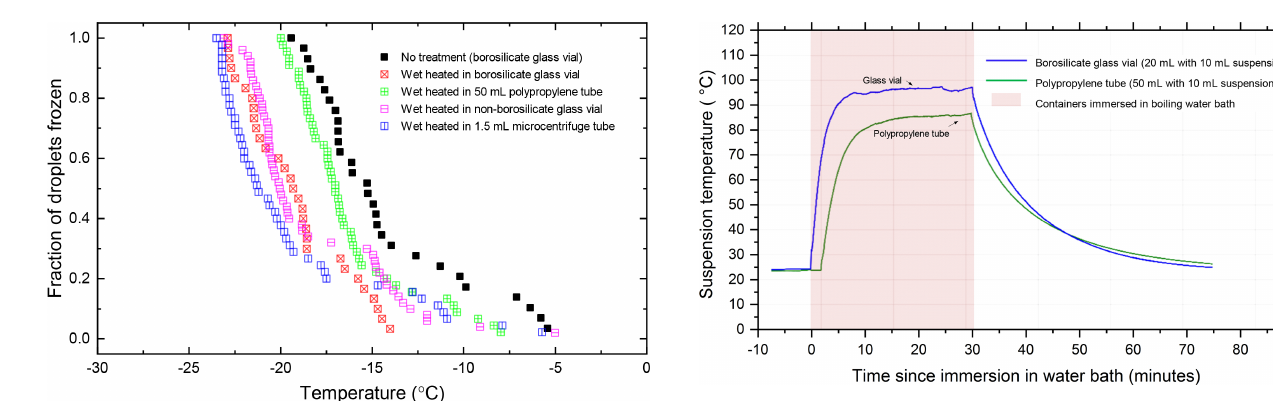
Figure A1. Plot showing the fraction of droplets frozen ( f ice (T ) ) for wet-heated Fluka quartz suspensions (all 1% w/v ) repeated us- ing a range of different container types.